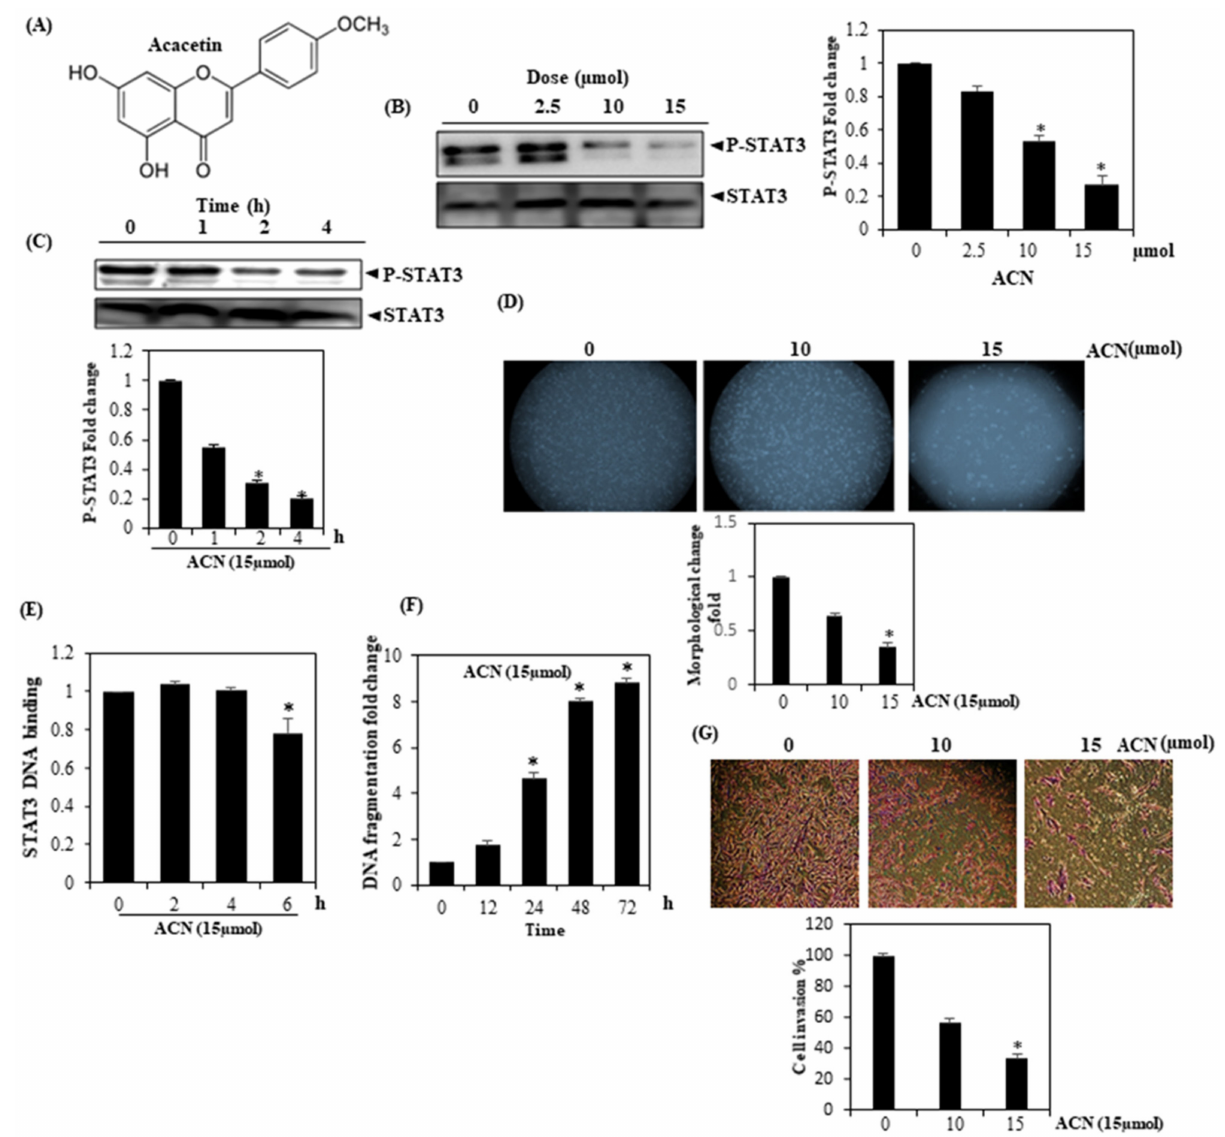
Figure 1. ( A ) Constitutively active STAT3 is inhibited by ACN. ( B ) p-STAT-3 levels are inhibited by ACN in a time-dependent manner. After treating HepG2 cells with indicated concentrations of ACN for 4 h, preparation of whole cell extracts was undertaken; protein weighing 50 mg was resolved over SDS-PAGE gel (10%) before being transferred to nitrocellulose membranes. ( C ) After treating HepG2 cells with ACN (15 µ mol/mL) for the indicated amounts of time, Western blotting was performed. STAT3 antibody was used to strip and again probe the blots to confirm that there were no discrepancies in protein loading. ( D ) Morphological examination of cells incubated with 15 µ mol/mL ACN for 24 h. ( E ) DNA-binding assay using nuclear extract protein (20 µ g) and ( F ) DNA fragmentation of cells treated with 15 µ mol/mL ACN for the indicated time points. ( G ) Observation of HepG2 cell invasion. The findings signify three experiments carried out independently (* p <